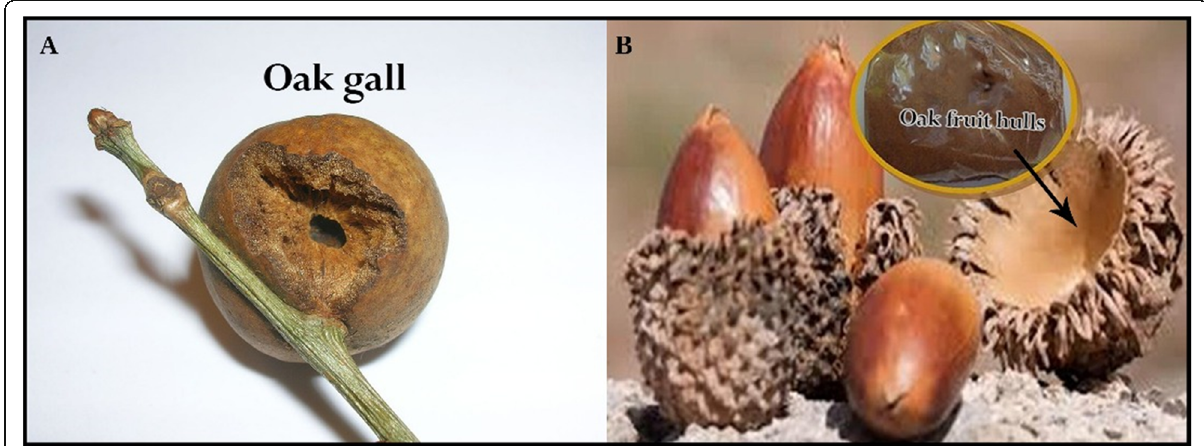
Fig. 1 a Oak gall (Mazo), b Oak fruit hulls